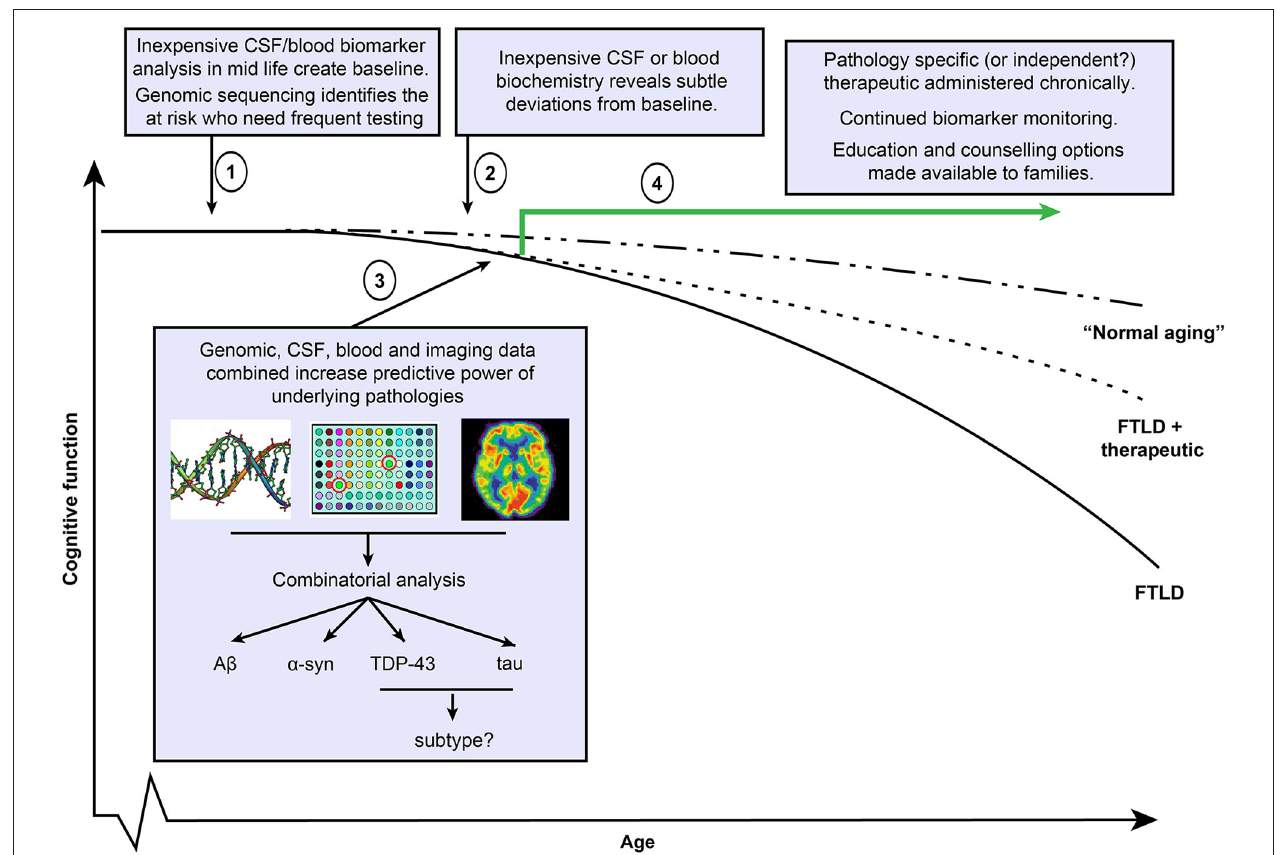
biomarker positivity or progression justifies the use of more expensive imaging methods to determine regional atrophy or using pathology binding agents (such as florbetapir or as yet incompletely characterized tau binding agents). Such data, when combined with CSF, blood and potentially genetic alleles that associate with pathologies or sub types of pathology, may provide potentially more predictive power than a reliance on a